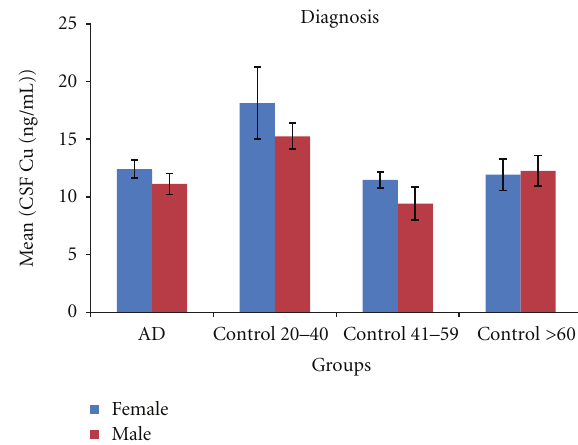
Figure 4: Cerebrospinal fluid (CSF) copper levels (mean ± SEM) in human AD and control subjects. CSF copper is significantly increased in female AD ( n = 16) compared to male AD ( n = 25) subjects ( P = 0 . 04), but there are no significant di ff erences in CSF copper between male and female healthy control